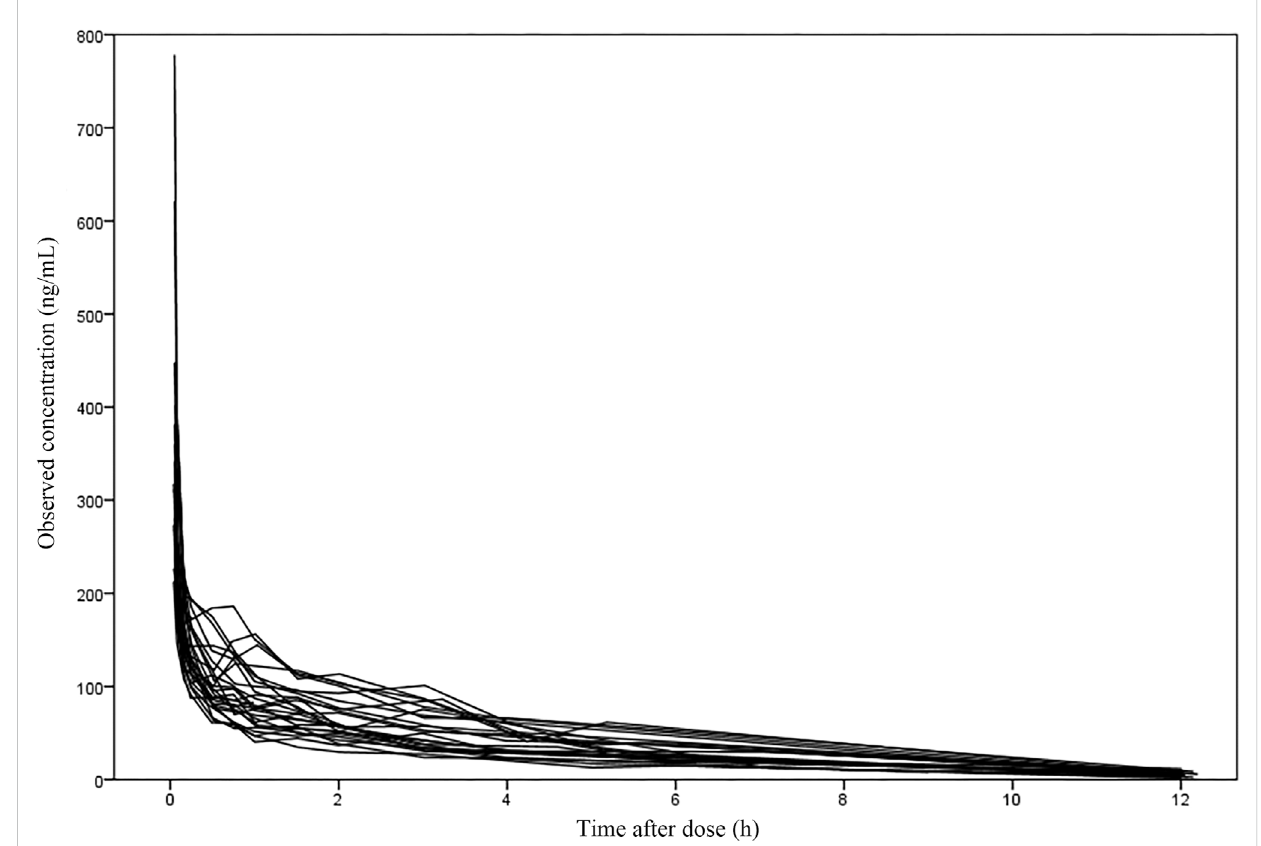
FIGURE 1 The concentration-time pro fi le of nalbuphine in the building group (27 subjects with 353